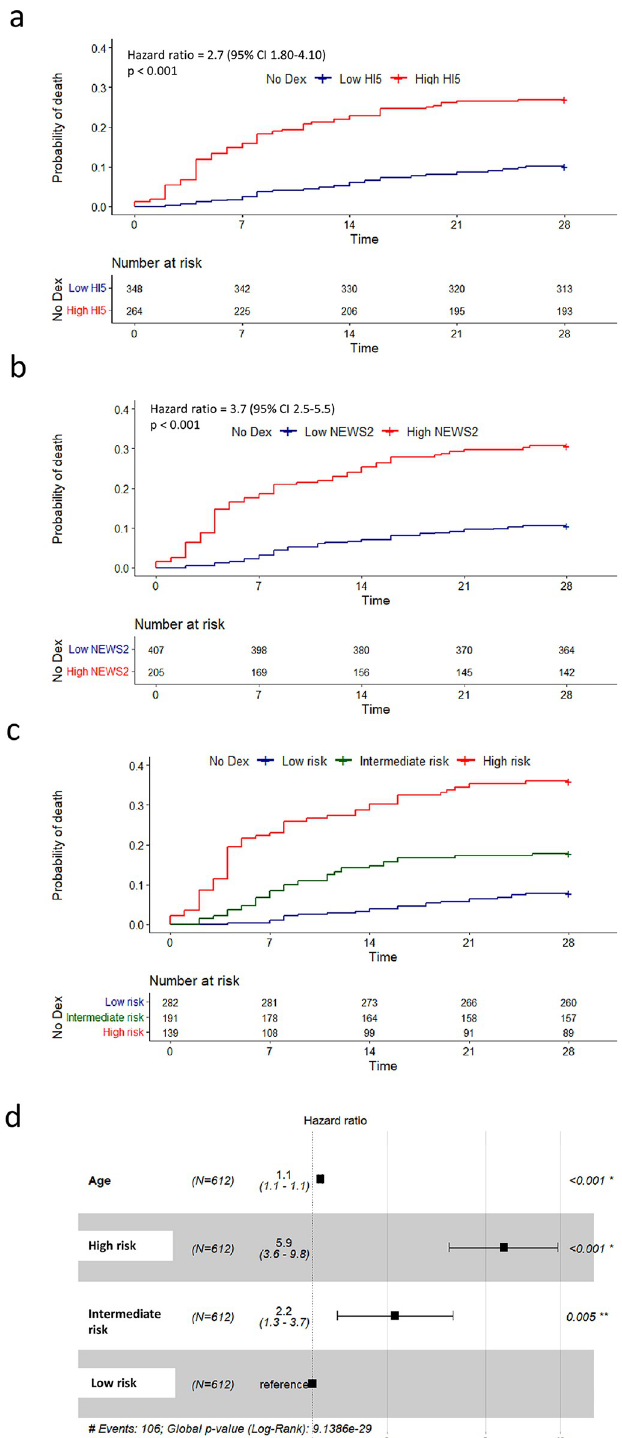
Fig 2. Mortality at day 28 in cases not treated with dexamethasone. Kaplan–Meier survival curves for 28-day mortality among patients who were not treated with dexamethasone with high (red line) or low (blue line) HI5 scores (a) or NEWS2 scores (b). Panel C, Kaplan-Meier survival curves for cases classified as high risk (High HI5 and High NEWS2, red line), intermediate risk (High HI5 or High NEWS2, green line), and low risk (Low HI5 and Low NEWS2, blue line). (d) Cox regression analysis for Age (per year of life), and HI5-NEWS2 risk status. All quoted hazard ratios are adjusted for age (aHR). At risk data are listed beneath plots. Time measured in